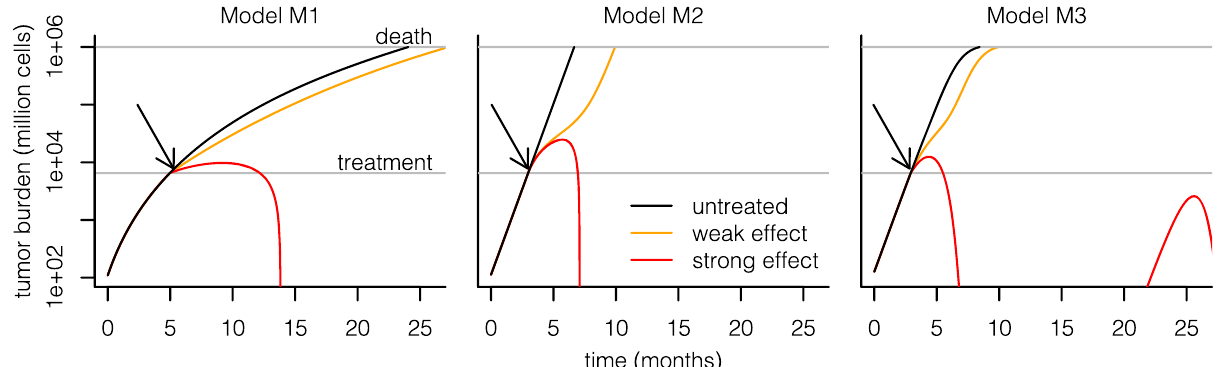
decreasedbythesamefactor.Thetreatmenteffectsizesarechosenpermodelsuch that there is a partial response (orange, leading to prolonged survival) or a com- plete response (red,leading to tumor eradication).The recurrence of the tumor in M3isaconsequenceofthemodel ’ sequations,whichleadtooscillatingdynamicsof the tumor burden rather than complete eradication in the complete response regime. Arrows indicate start of